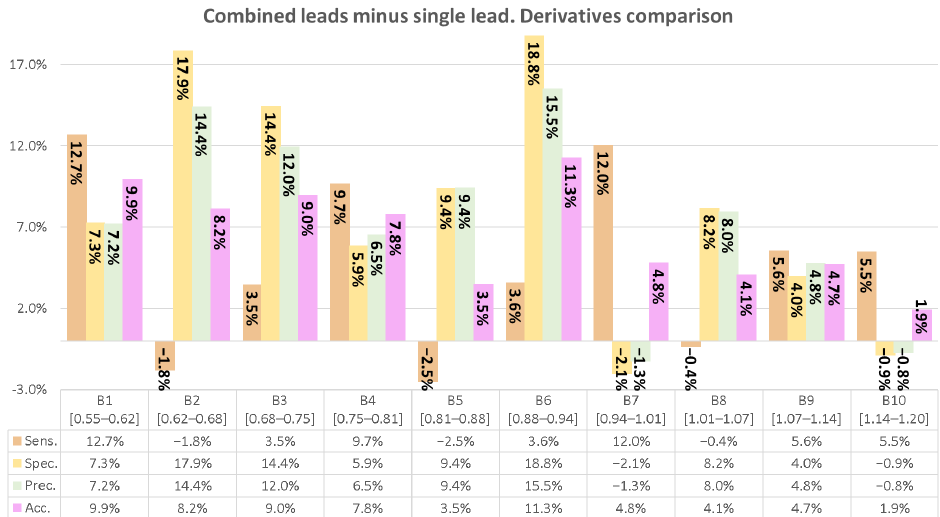
Figure 11. Combined leads vs. single lead: Score